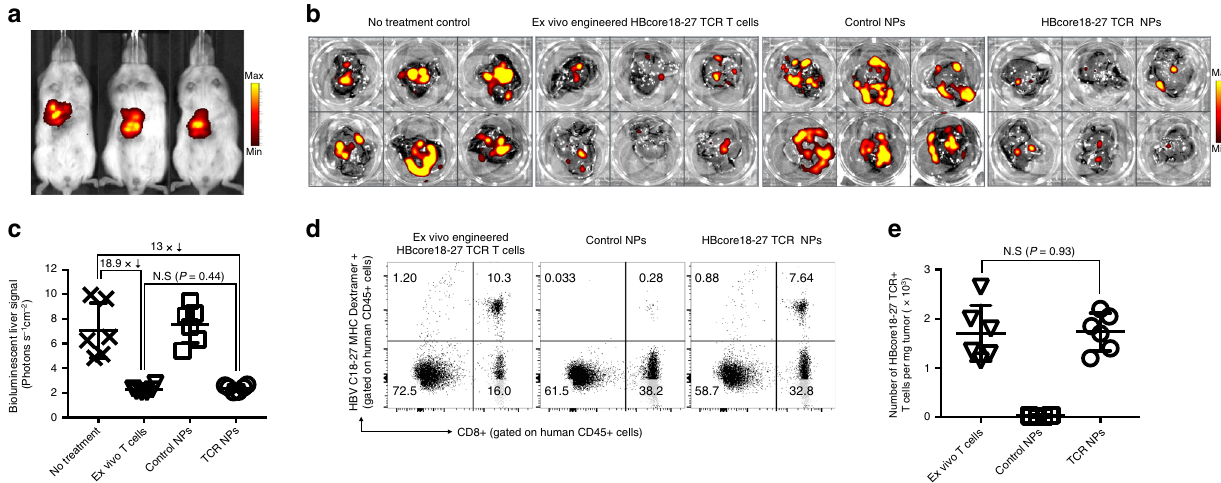
Fig. 8 In situ programming of HBV-speci fi c T cells using nanoparticles loaded with TCR transgenes. a We established a mouse xenograft tumor model of HBV-induced HCC. HepG2 cells stably transduced with HBcAg and luciferase were surgically injected into the liver of NSG mice reconstituted with human T cells. Three weeks post-implantation, HepG2 tumors were visualized by in vivo bioluminescent imaging and assigned to nanoparticle (6